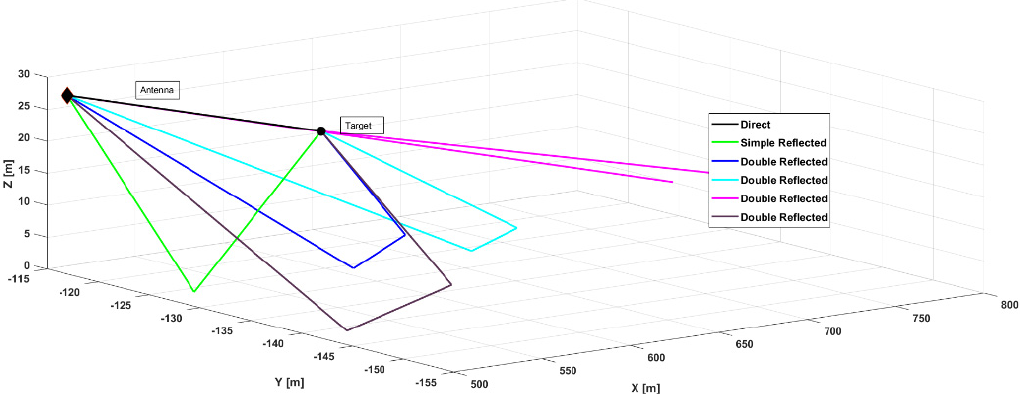
Figure 7. Different rays and effects computed by NewFasant software.